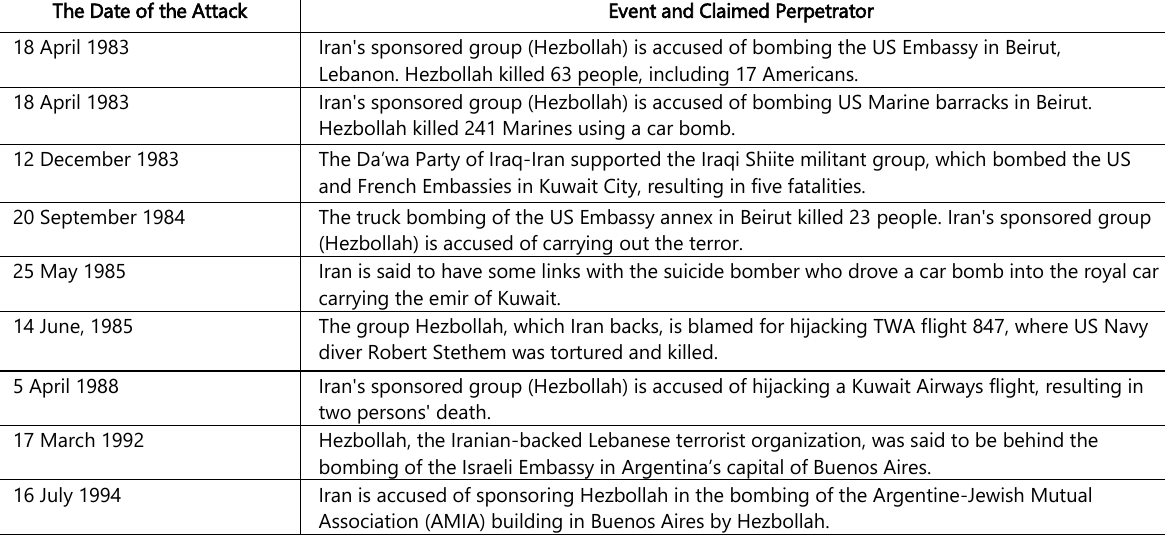
Table 2: The List of Iran‟s Alleged Involvement in Terrorist Attack (Source: Katzman